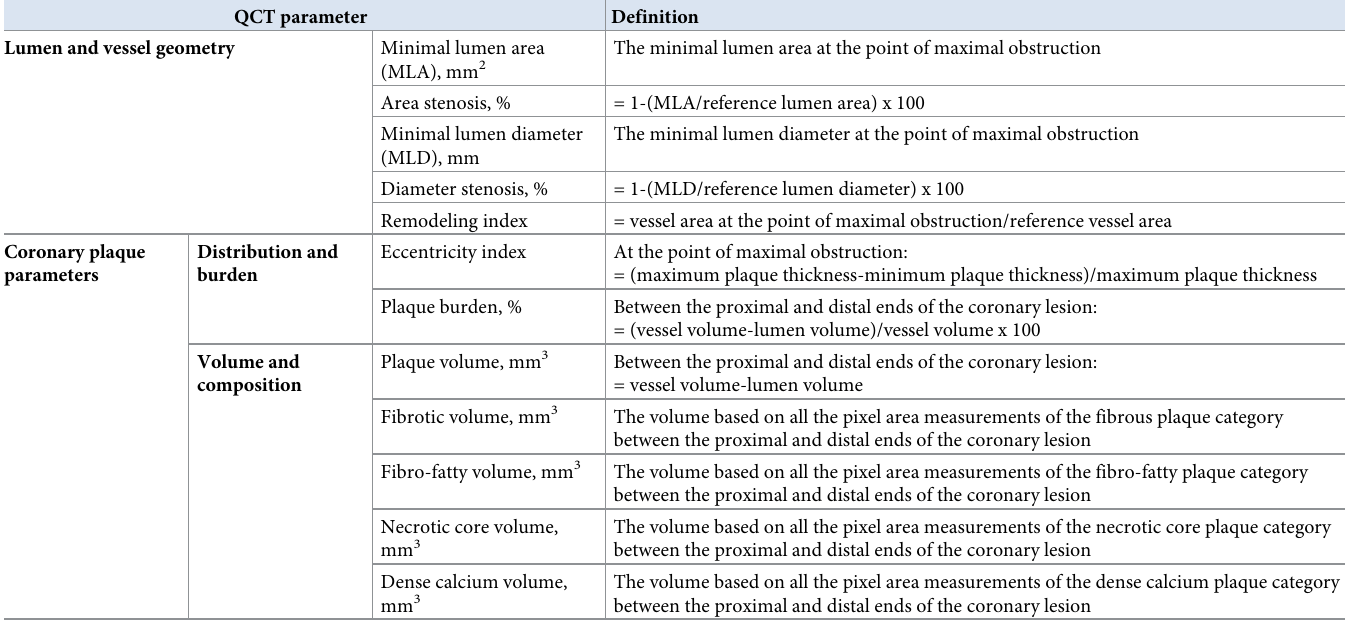
Table 1. Definitions of quantitative computed tomography (QCT) derived